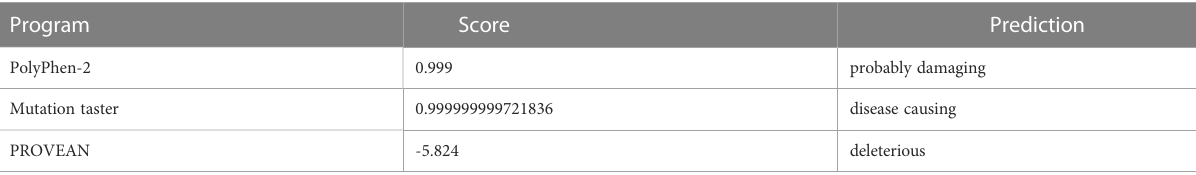
TABLE 2 Prediction of the pathogenicity of S408L by a range of soft